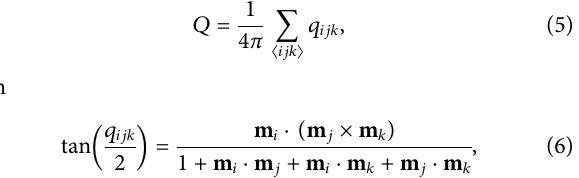
Frontiers in Physics |